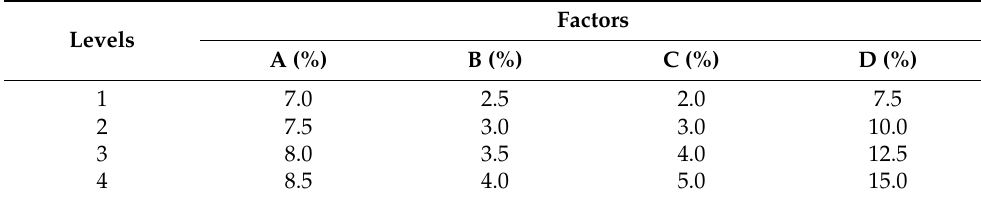
Table 2. Factor levels of orthogonal